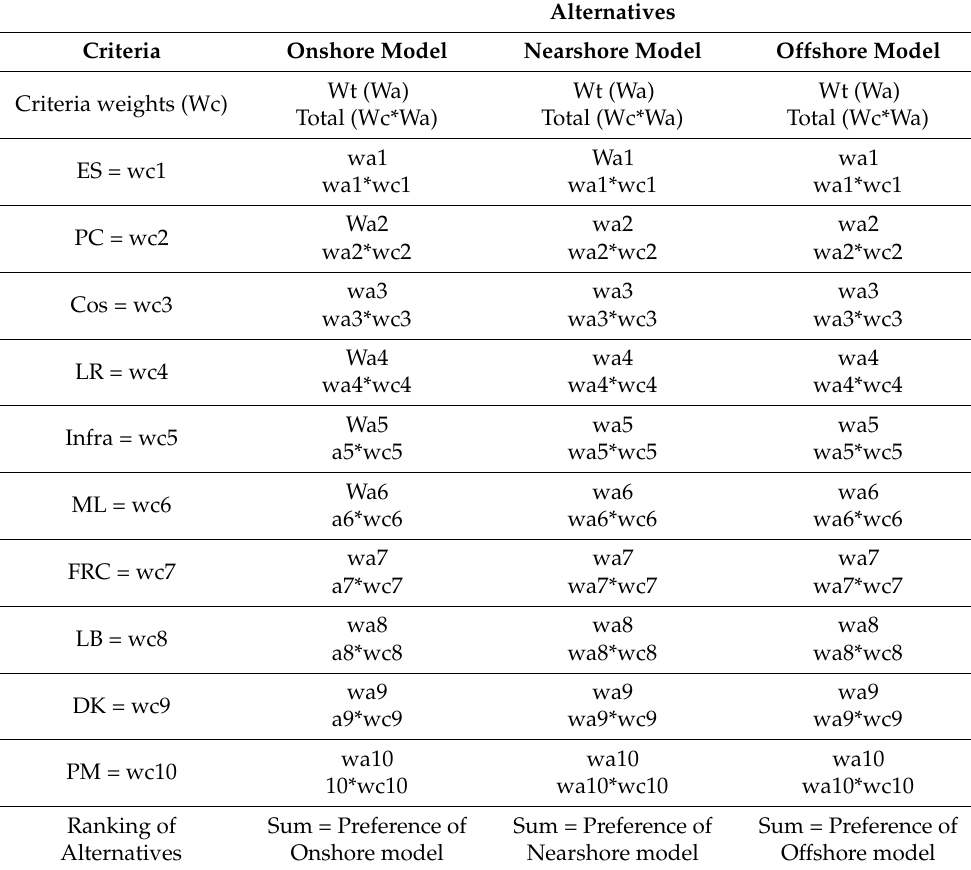
Table 10. Identifying ranking of the given